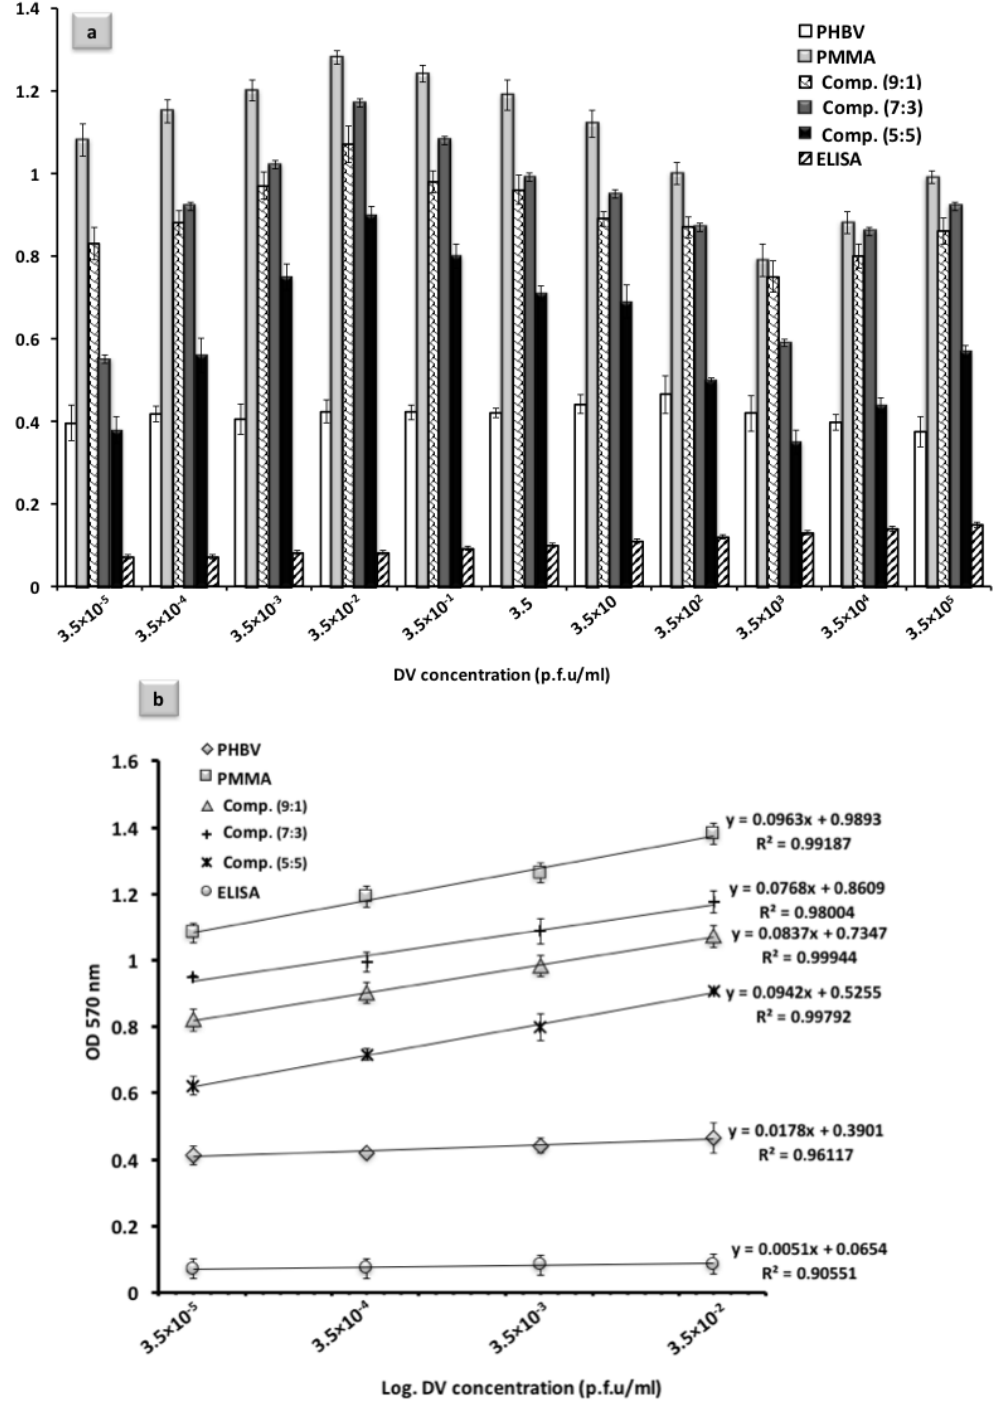
Figure 5. Detection range ELISA results: ( a ) coated and uncoated electrospun PHBV fiber mats in comparison to the conventional ELISA (depicted results are plotted after excluding the cut-off values); ( b ) calibration curves obtained for the assay conducted at DENV (dengue virus) concentration range of 3.5 × 10 − 2 p.f.u/mL to 3.5 × 10 − 5 p.f.u/mL.